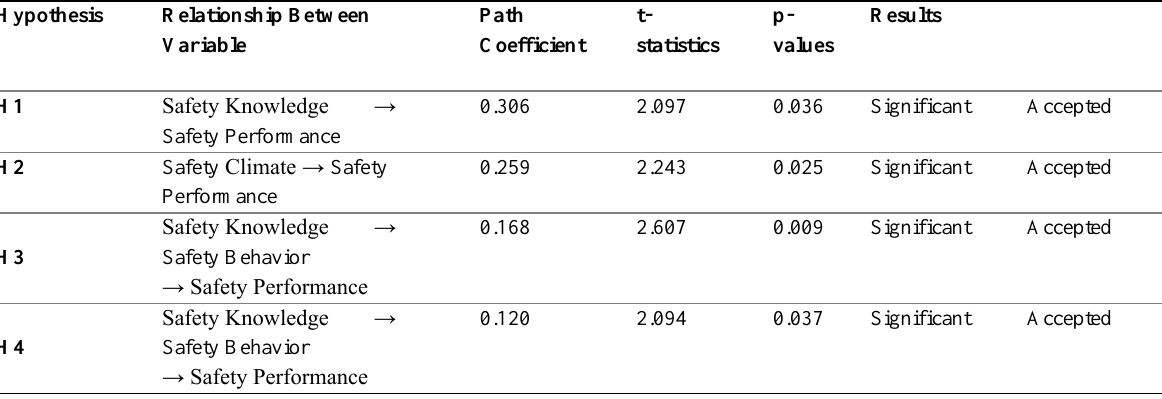
Table 2: Hypothesis Testing